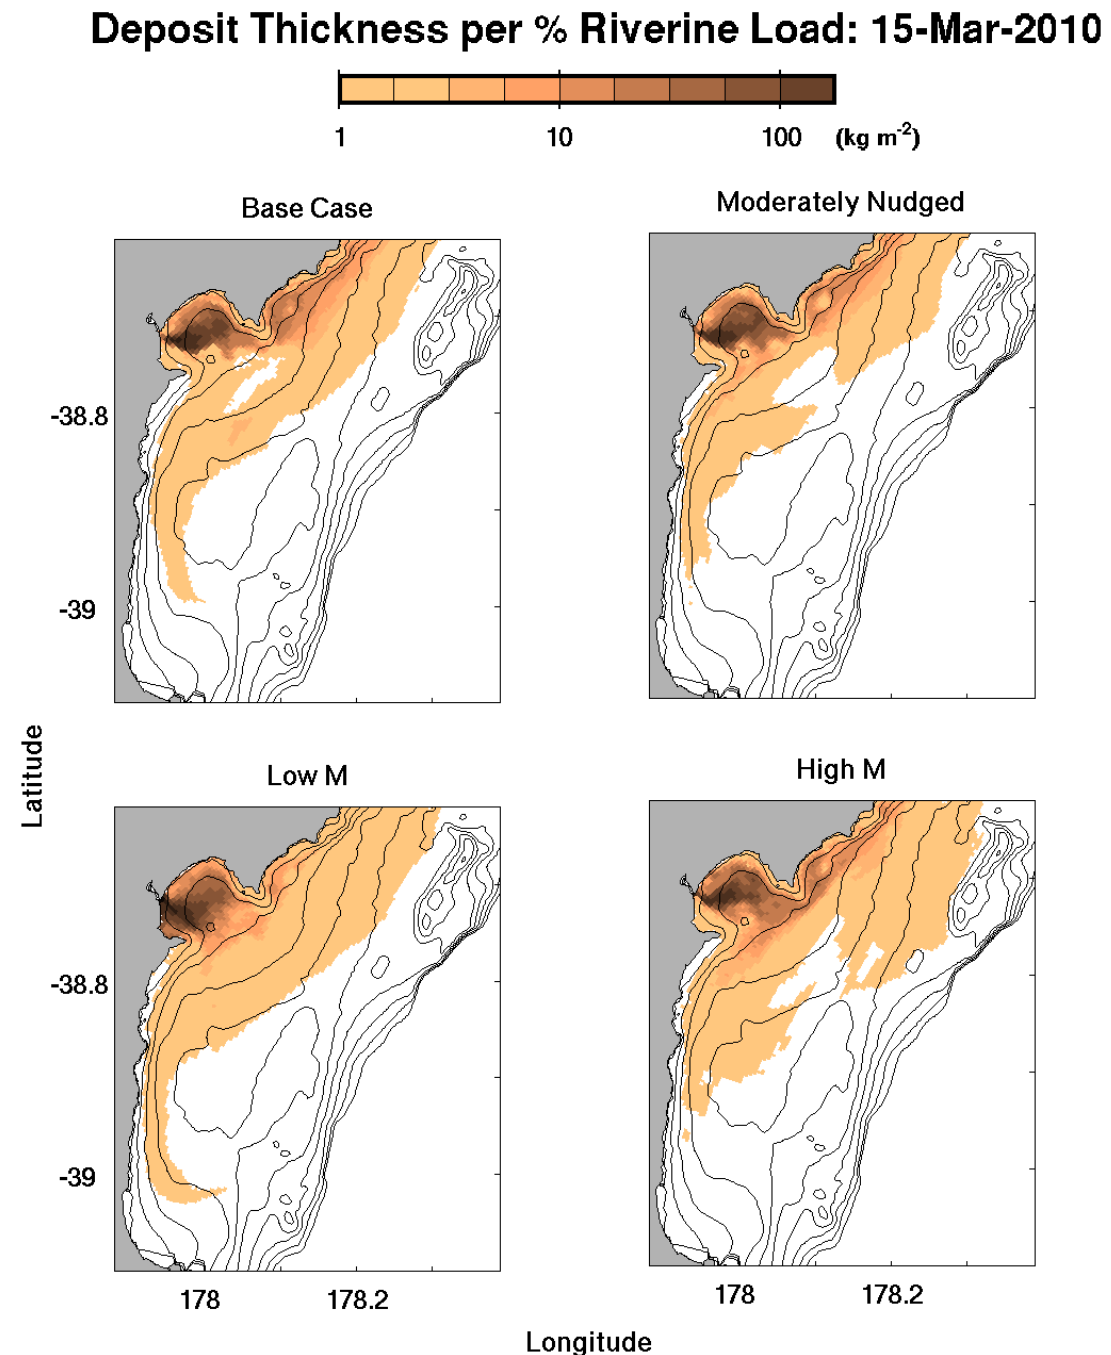
Figure 12. Deposition per percent of riverine load following the March wave event for standard, moderately-nudged, low M and high M